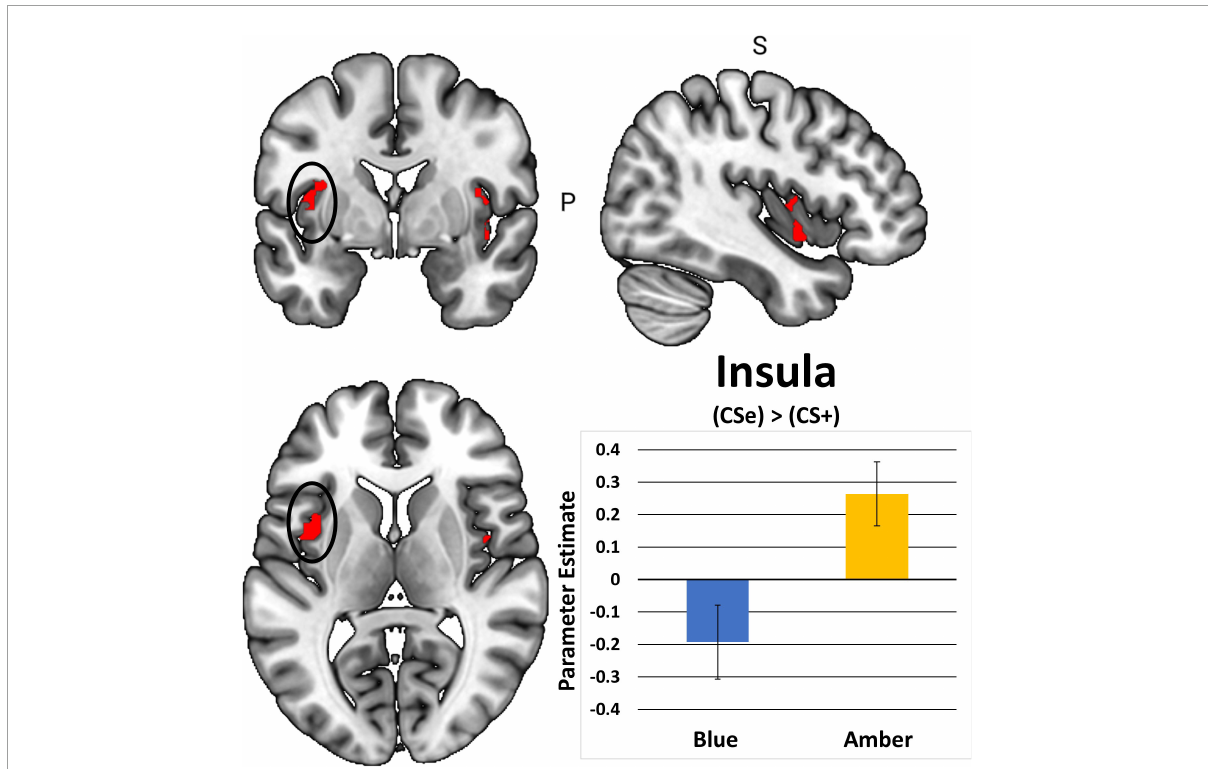
FIGURE7 The contrast between extinguished (CS + E) versus unextinguished (CS +) was compared between the BLUE and AMBER conditions at post-treatment. Participants in the amber light condition showed a significant increase of activation in the bilateral insula areas, with the left insula activation (circle) surviving FWE correction. Error bars represent standard error of the